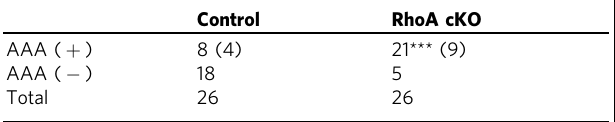
Numbers in () indicate the deaths by rupture of AAA.